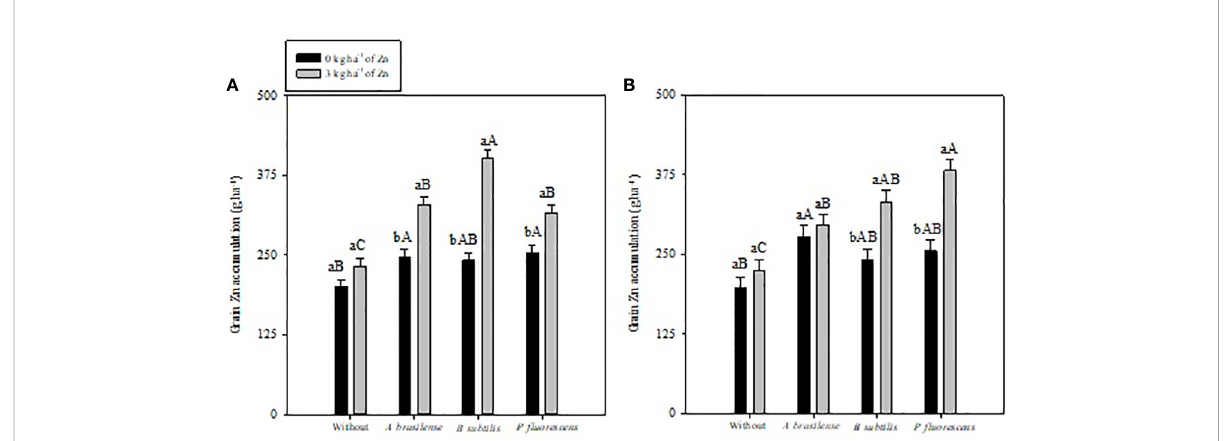
FIGURE 4 Maize grain zinc (Zn) accumulation in 2019 – 20 (A) and 2020 – 1 (B) as a function of plant growth-promoting bacteria with or without foliar zinc oxide (ZnO) application. Without = control (no inoculation). The uppercase letters compare interactions of inoculations within each dose of foliar nano-ZnO application and lowercase letters are used to compare interactions of foliar Zn doses (presence and absence) within each inoculation treatment. The identical alphabetic letters do not differ from each other by Tukey ’ s test ( p < 0.05) for foliar ZnO doses and inoculations in the 2019 – 20 and 2020 – 1 cropping seasons. Error bars indicate standard error of the mean ( n = 4